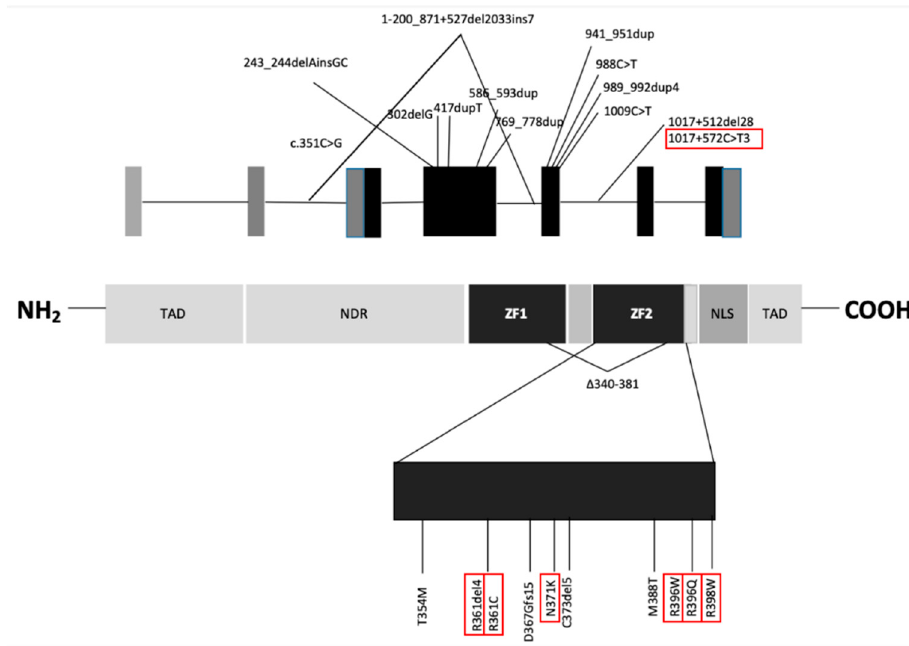
Figure 1. GATA2 gene and protein structure. GATA2 gene and protein structure. Mutations most frequently associated with MDS are circled [7]. TAD: transactivation domain, NRD: negative regulatory domain, ZF: zinc-finger domains, NLS: nuclear localization signal.